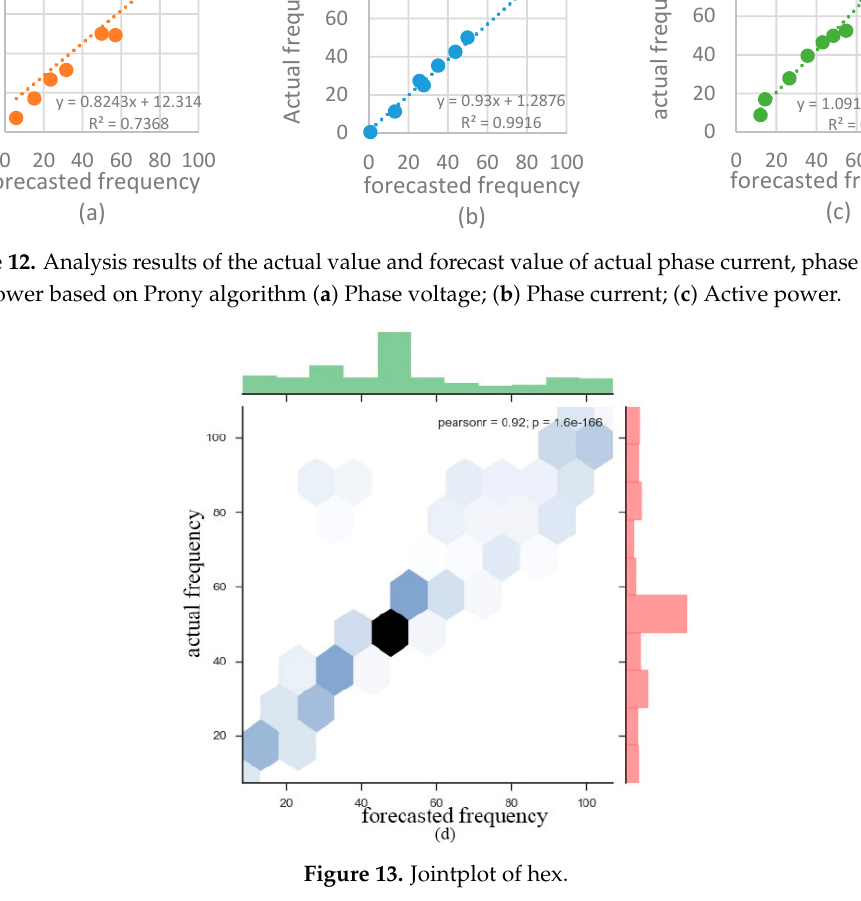
Table 7. Analysis of Oscillation Mode of Wind Turbine on Actual Phase Current, Phase voltage and Power. Observation Object\Oscillation Mode